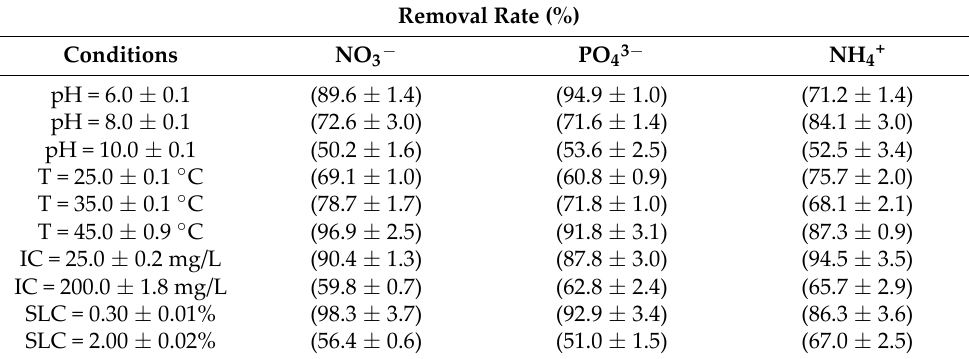
Table 1. Maximum and minimum values of the removal rates of nitrate, phosphate, and ammonium ions under different conditions of pH, temperature, and